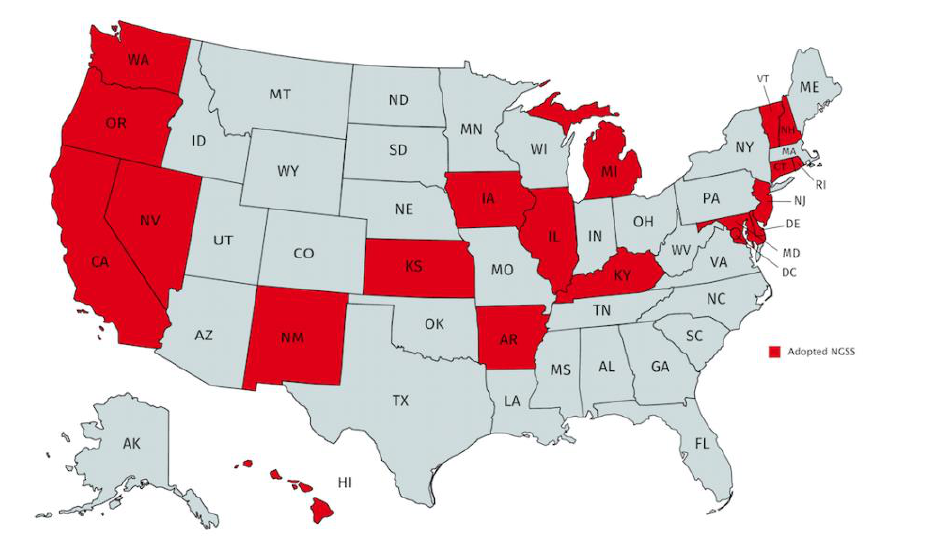
Figure 2: Map of states that adopted NGSS as of November 2017 (NSTA,